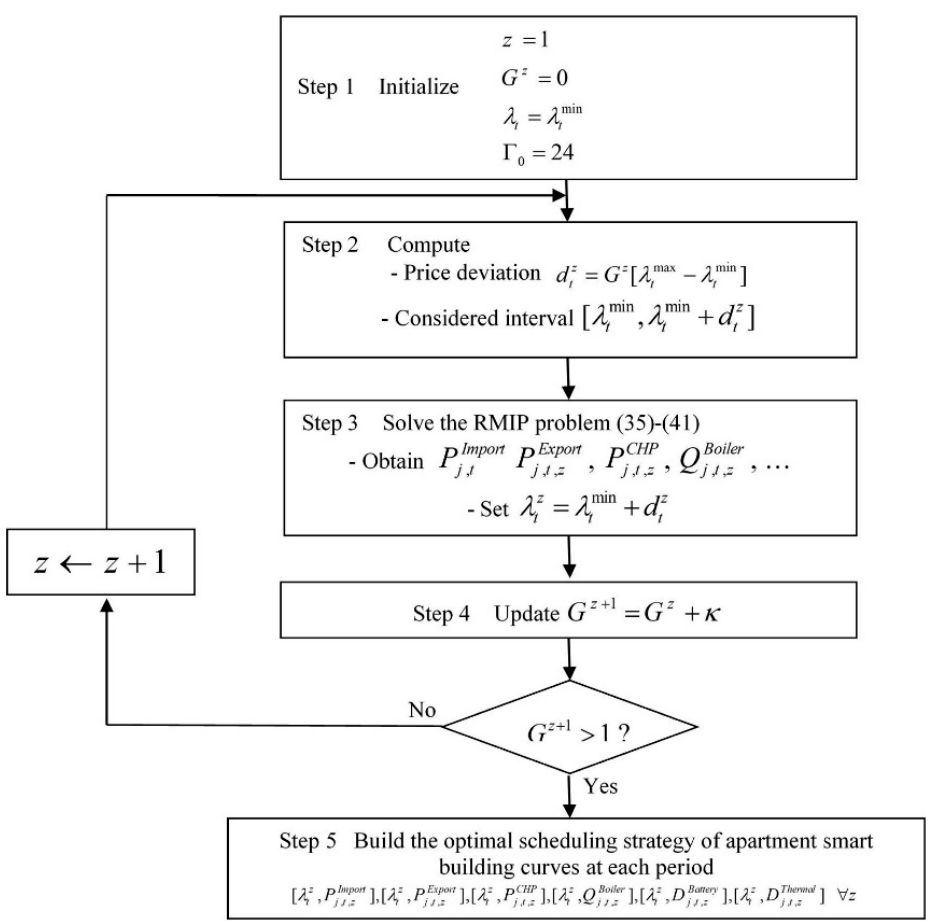
Figure 10. Example of Mixed-Integer Linear Programming (MILP) implementation in a Combined Heat and Power (CHP) system [170]. Table 4. Selected preliminary studies on energy system optimization using the MILP method.